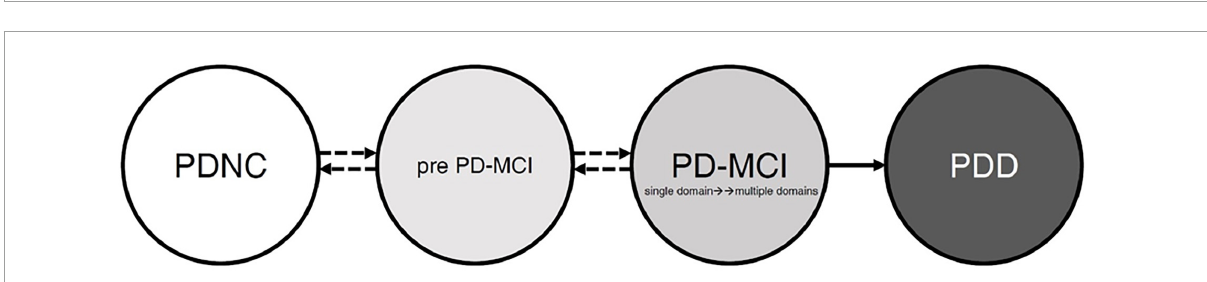
FIGURE2 The possible patterns and evolution of cognitive function in patients with Parkinson’s disease. Before full-blown dementia, the PD patients’ cognitive patterns may be in the “PDNC,” “pre PD-MCI,” or “PD-MCI.” The pathway from PD-MCI to PDD is relatively stable; however, the three cognitive states may transition before entering into PDD. PDNC, PD patients with normal cognition; pre PD-MCI, PD patients do not achieve PD-MCI diagnosis but have cognitive impairment; PD-MCI, PD patients achieve PD-MCI diagnosis; PDD, PD patients with